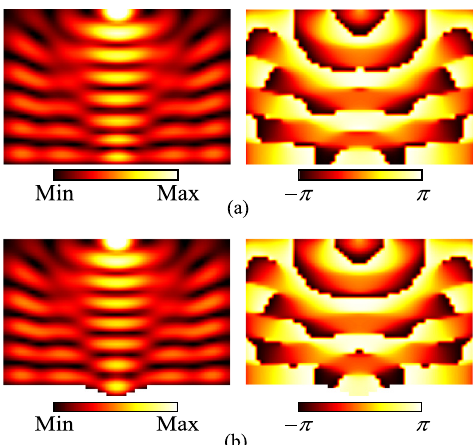
Fig. 23. Calculated complex voltage distributions corresponding to measured results in Figure 22. Left: Amplitude. Right: Phase. (a) With the groove illusion medium. (b) With the original